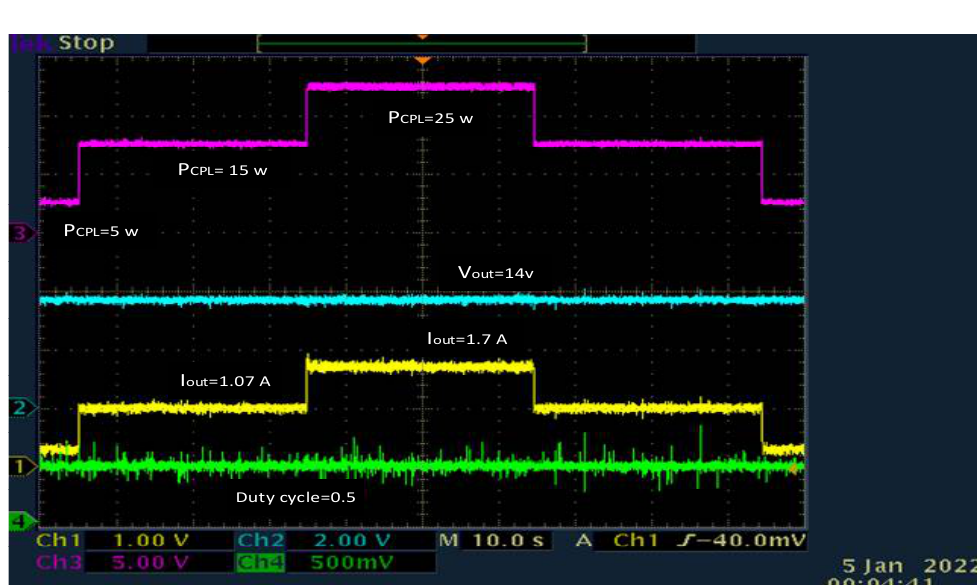
Figure 13. Block diagram of experimental HIL.